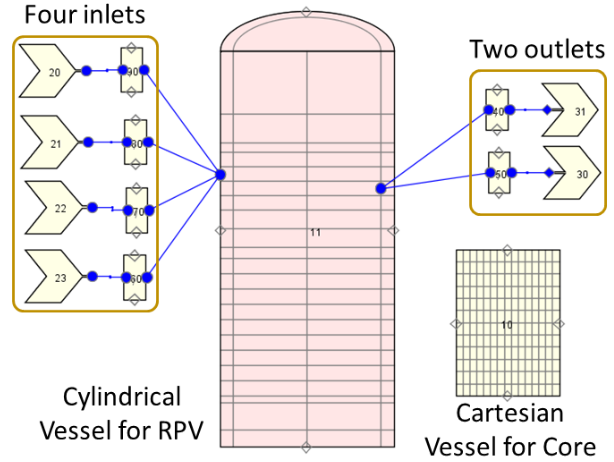
Figure 7. The AP1000 model uses the new method to handle the new multi-vessel coupling.